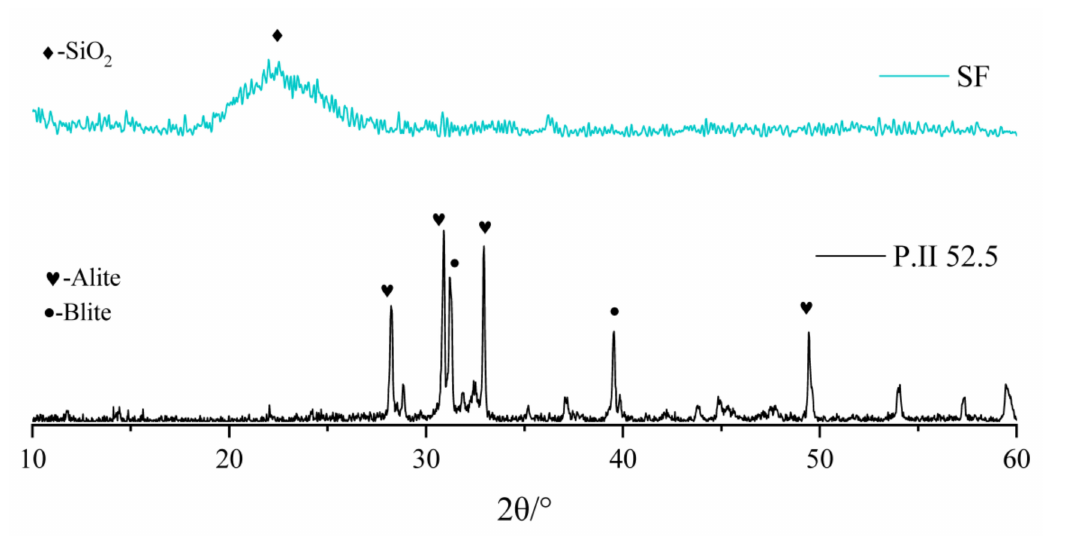
Figure 2. XRD pattern of used